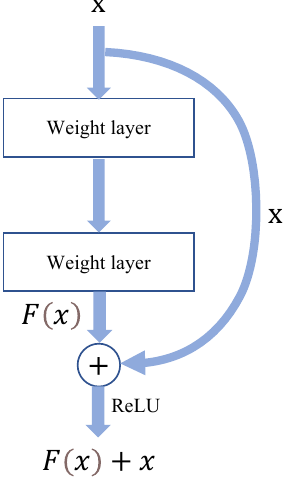
Figure 3. The structure of residual